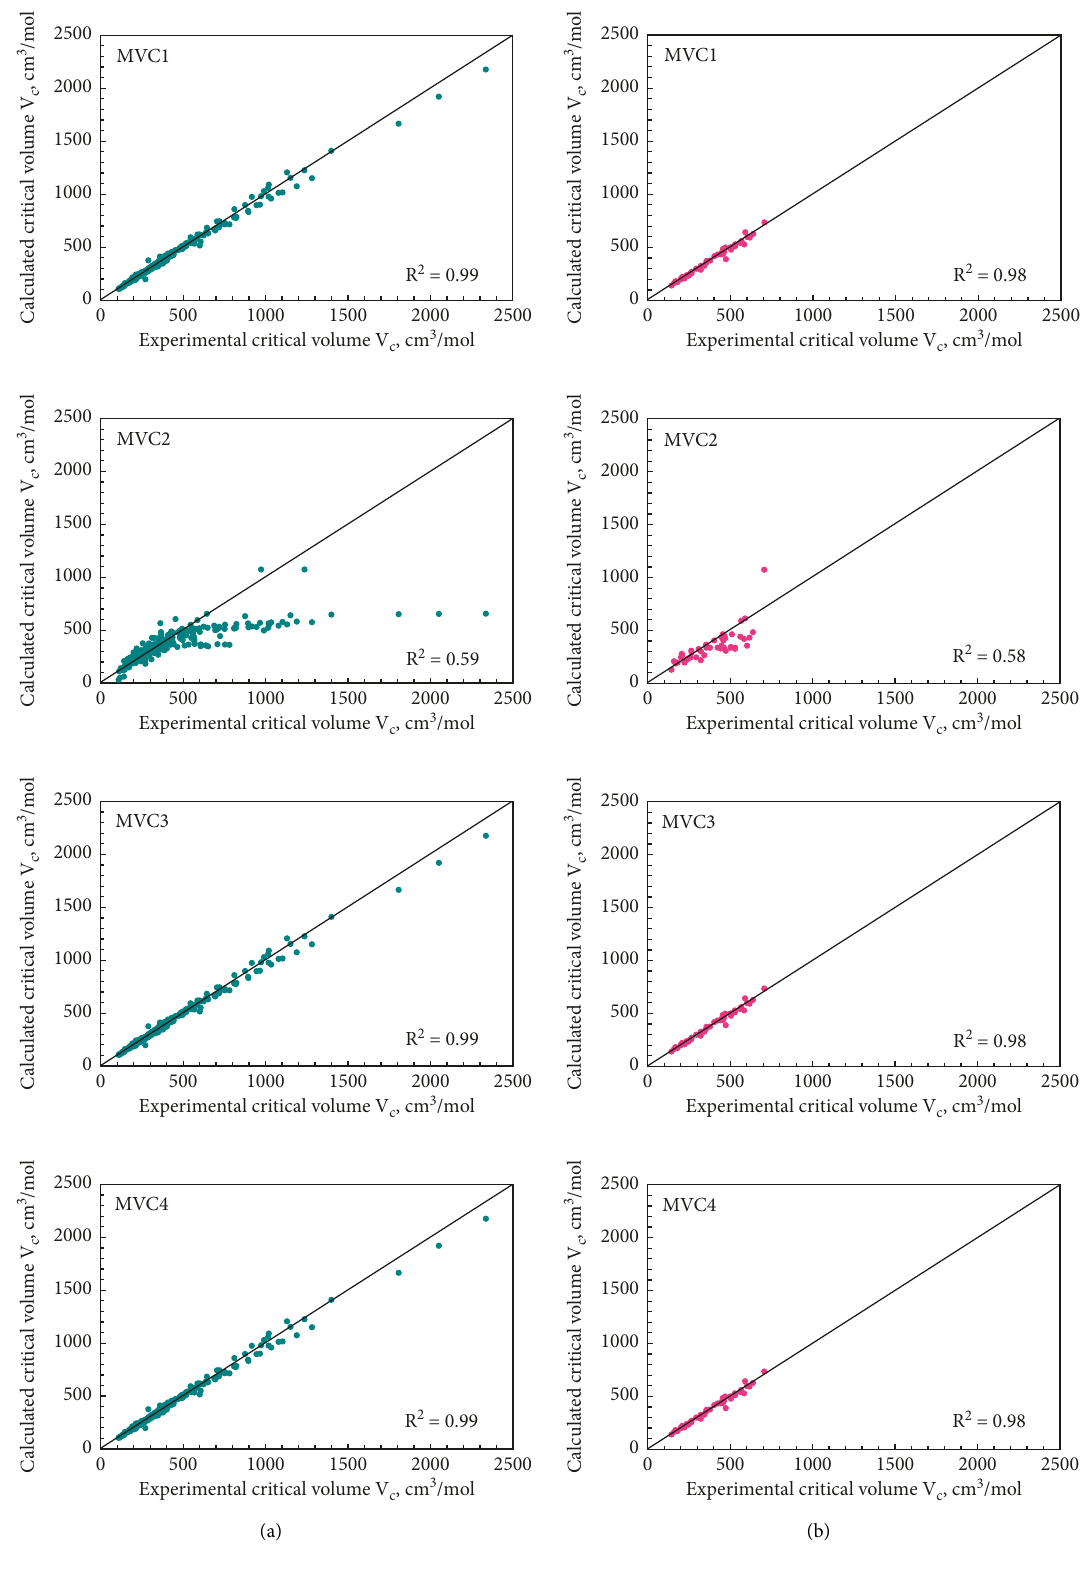
Figure 7: Results of the calculation of critical volume of pure compounds using different first-order GCMs. (a) Correlation and (b)